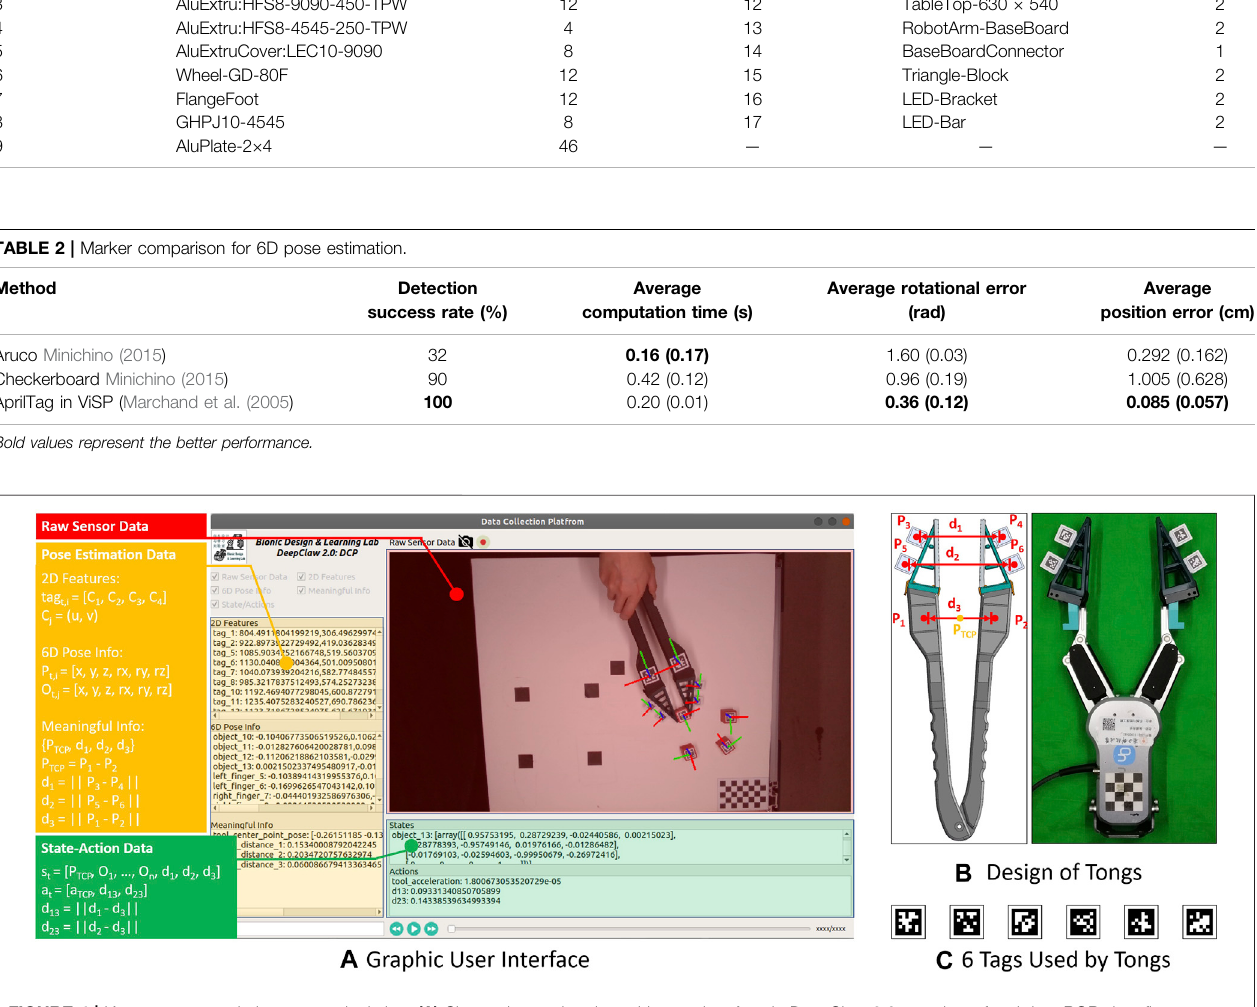
Frontiers in Robotics and AI |